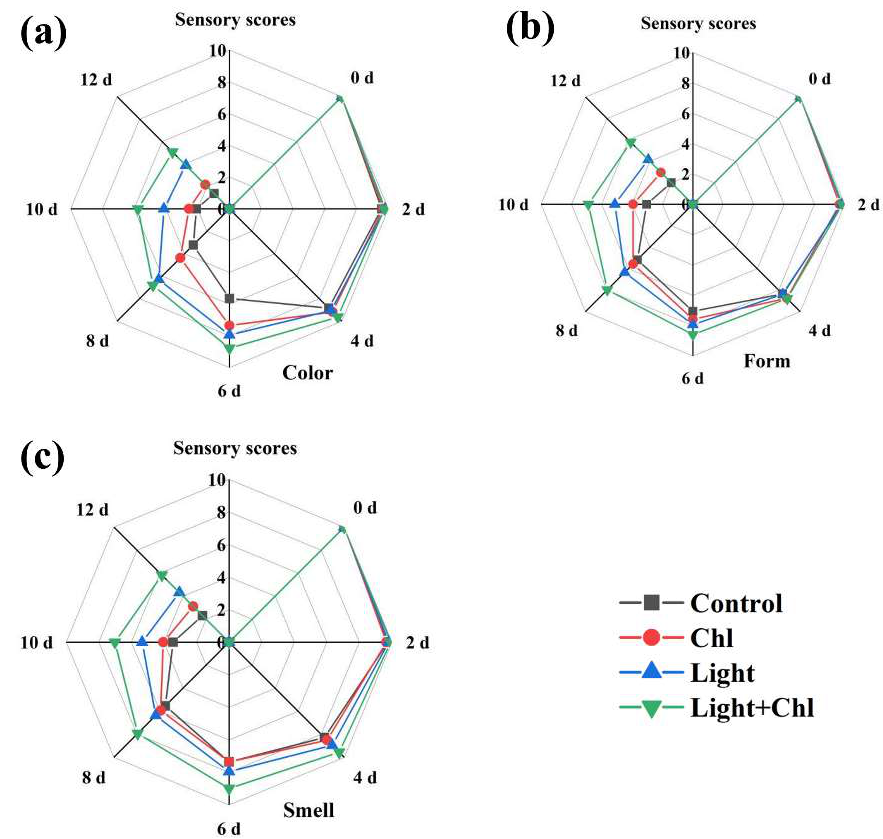
Figure 8. Changes in color ( a ), form ( b ) and smell ( c ) of organoleptic properties’ results in different groups.